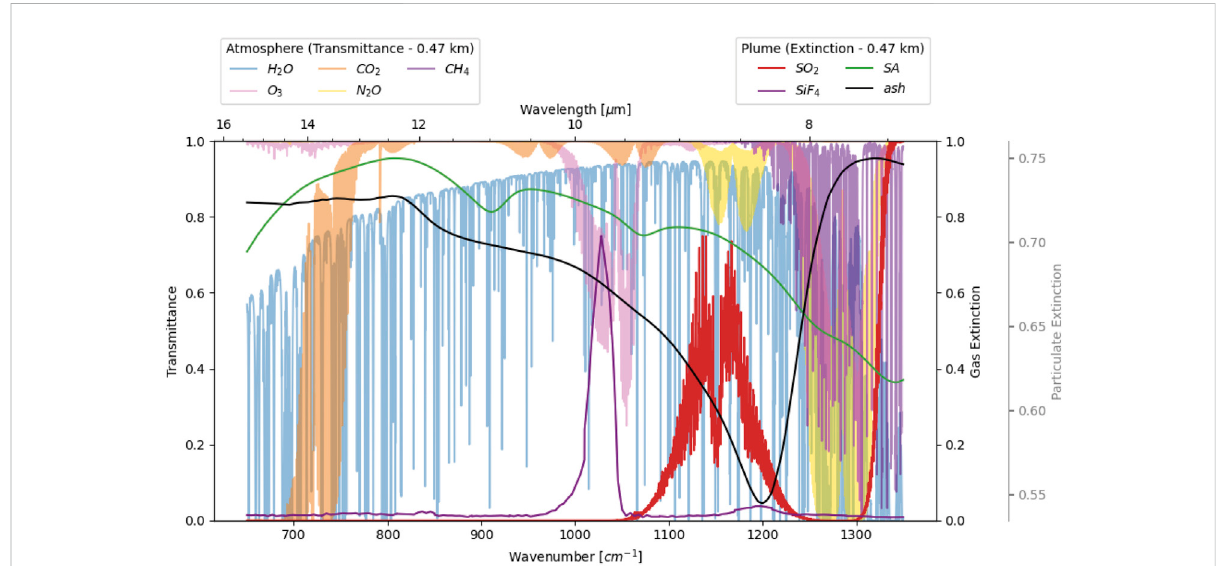
FIGURE 4 Reference spectra for the gases and particles considered in the retrieval. The transmittance of the atmospheric gases in layer two is shown in lighter shades [axis on the left], while the extinction of the plume species is shown in darker shades [axes on the right]. Note that the particulate species are plotted on a separate y -axis [offset to the right in grey] to emphasize their spectral features. Volume mixing ratios for each species were chosen to emphasize spectral shapes and are not necessarily representative of the actual quantities encountered during the retrieval process, except in the case of H 2 O, where we show the actual transmittance at plume height. Note the strong water vapour continuum